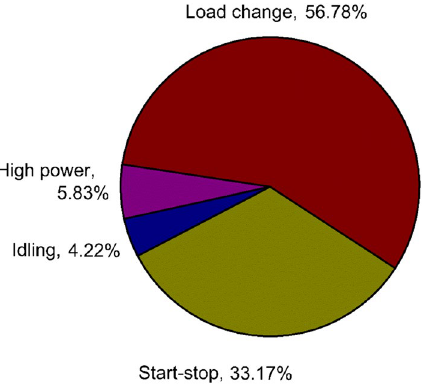
Figure 1. Degradation percentages of different operating conditions in a